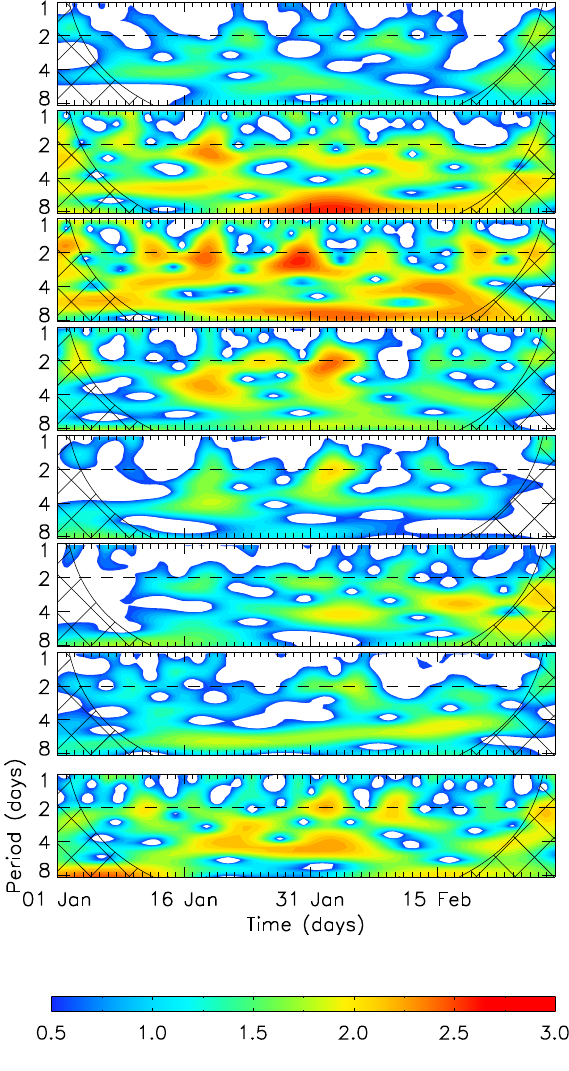
Fig. 4. Space-scale energy density in log-scale of the amplitude of the semidiurnal tide (0.40–0.60 days) in January-February 2003 for the eight magnetic stations (from top to bottom): ASC, SLZ, HUA, TIR, PND, BNG, GUA, and